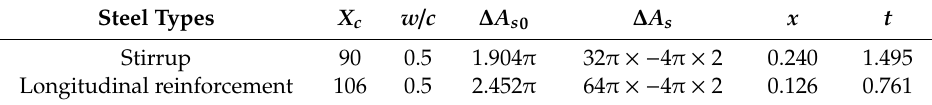
Figure 2. Longitudinal reinforcement and stirrup material properties: ( a ) Corrosion rate; ( b ) Diameter; Figure 2 ( c ) Elastic modulus; ( d ) Yield strength. Table 1. Parameter analysis when the concrete surface crack reaches 1